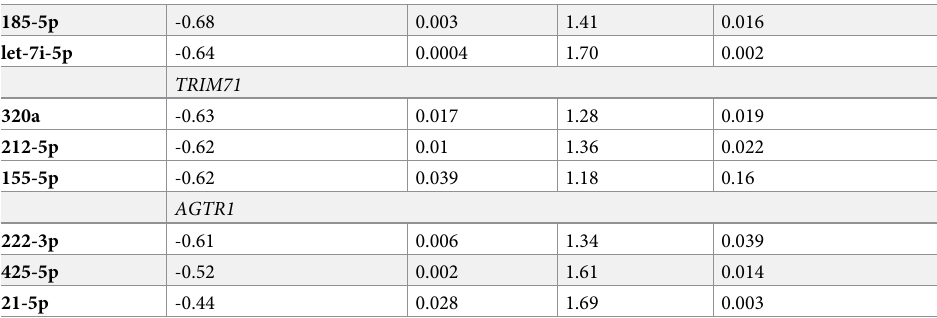
FC = fold change; FDR = false discovery rate; HR = hazard ratio: OS = overall survival since diagnosis.